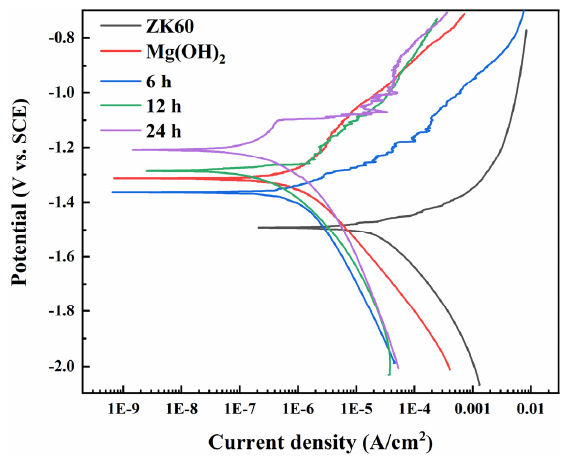
Figure 4. Polarization curves of ZK60 magnesium substrate and film samples.